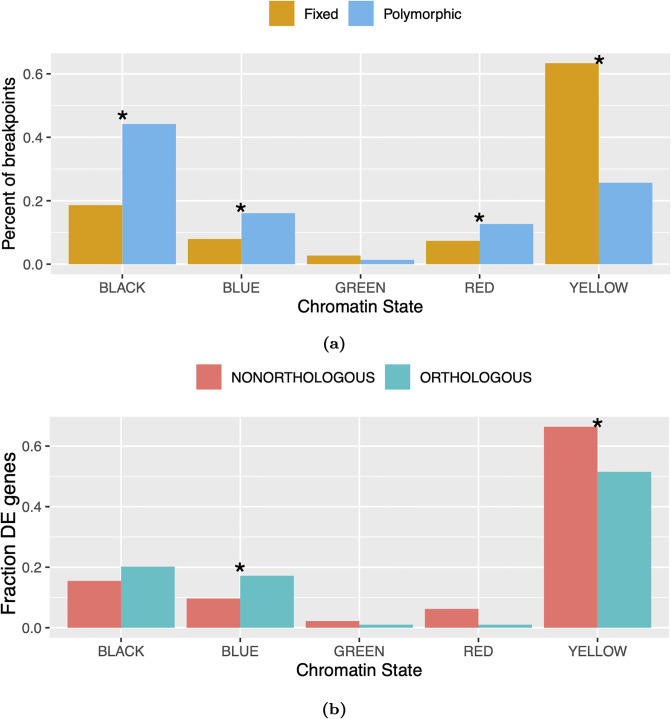
Evolutionary constraint of TADs by chromatin state.A) To assess whether TAD subtypes are under different levels of evolutionary constraint, we compared the frequency of polymorphic versus fixed intra-TAD rearrangement breakpoints across chromatin states. We found that interspecies rearrangement breakpoints that disrupt TADs are significantly depleted from the BLACK, BLUE, and RED chromatin states, and significantly enriched in the YELLOW chromatin state. These results suggest that rearrangement breakpoints from BLACK, BLUE, and RED states are under purifying selection, while some of the rearrangements in YELLOW states may have been fixed due to positive selection. Asterices * indicate significant differences as calculated by Fisher’s Exact Test (p-values: BLACK = 5.118e–17; BLUE = 9.714e–5; GREEN = 0.136; YELLOW = 2.352e–29; RED = 0.005). B) Y-axis represents fraction of differentially-expressed (DE) genes assigned to each chromatin state. DE genes from the YELLOW chromatin state are more likely to be located in disrupted (i.e. nonorthologous) TADs compared to conserved (i.e. orthologous) TADs, whereas the opposite is true for genes from the BLUE chromatin state. Asterices * indicate significant differences as calculated by Fisher’s Exact Test (p-values: BLACK = 0.156; BLUE = 0.026; GREEN = 0.381; YELLOW = 0.004; RED = 0.123).